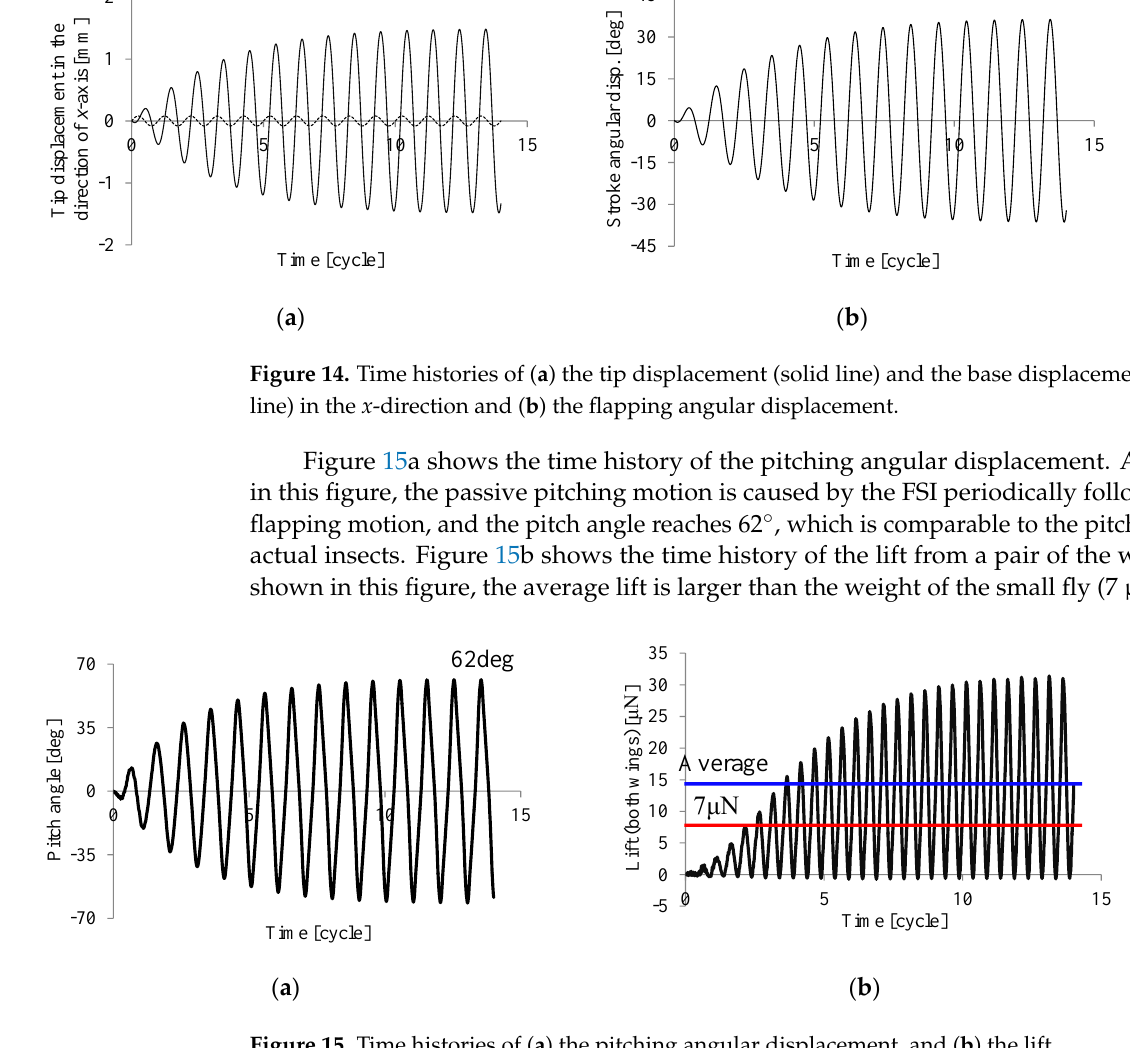
Figure 15. Time histories of ( a ) the pitching angular displacement, and ( b ) the lift.